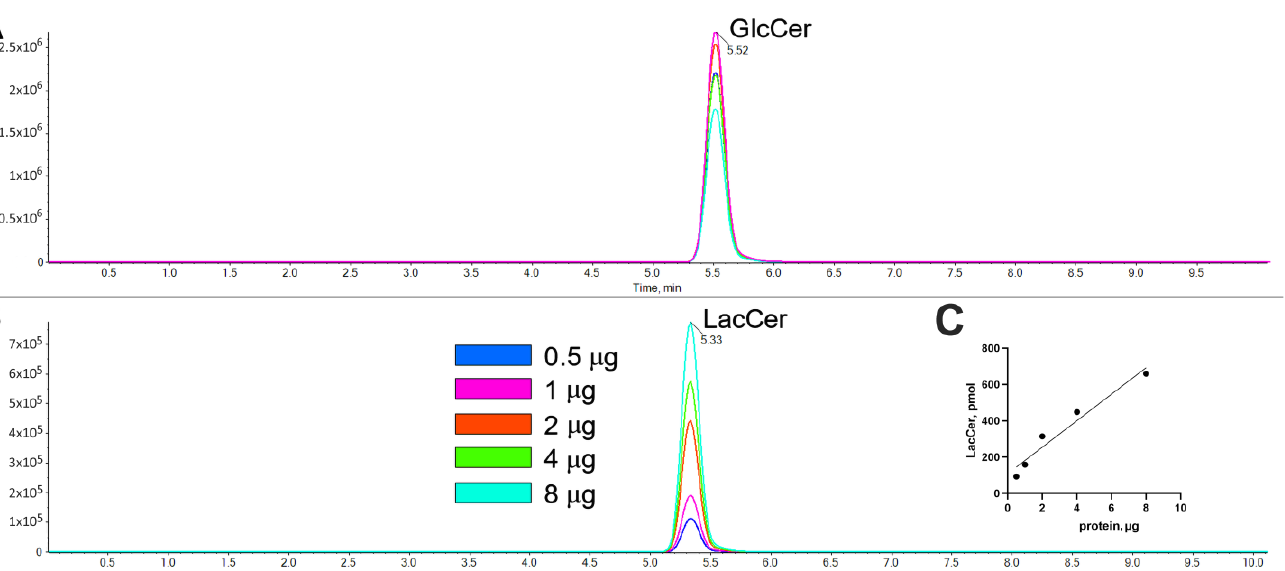
Figure 7. Characterization of LacCer synthase activity detected with GlcCerd7 and LC-MS/MS. De- pendence of the activity expressed in HEK-B4GALT5 on the concentration of Mn ++ or CDP-Choline (Panel ( A )). Activity measured in HEK-B4GALT5 after different times of incubation (Panel ( B )) or using different amounts of homogenate protein (Panel ( C )). Dependence of the activity expressed in HEK-B4GALT5 on the concentration of the donor substrate UDP-Gal at fixed saturating concen- tration of GlcCerd7 (10 μM). The Hanes – Woolf plot of activity values, presented in red (secondary axis), was used for calculating kinetic constants (Panel ( D )). Dependence of the activity expressed in HEK-B4GALT5 on the concentration of the acceptor substrate GlcCerd7 at a fixed saturating